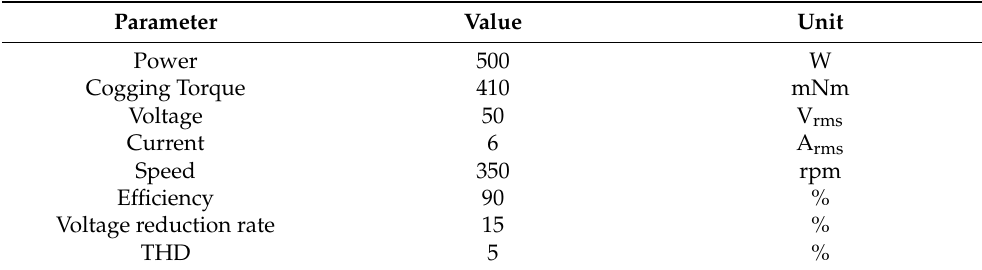
Table 1. Generator target specifications.